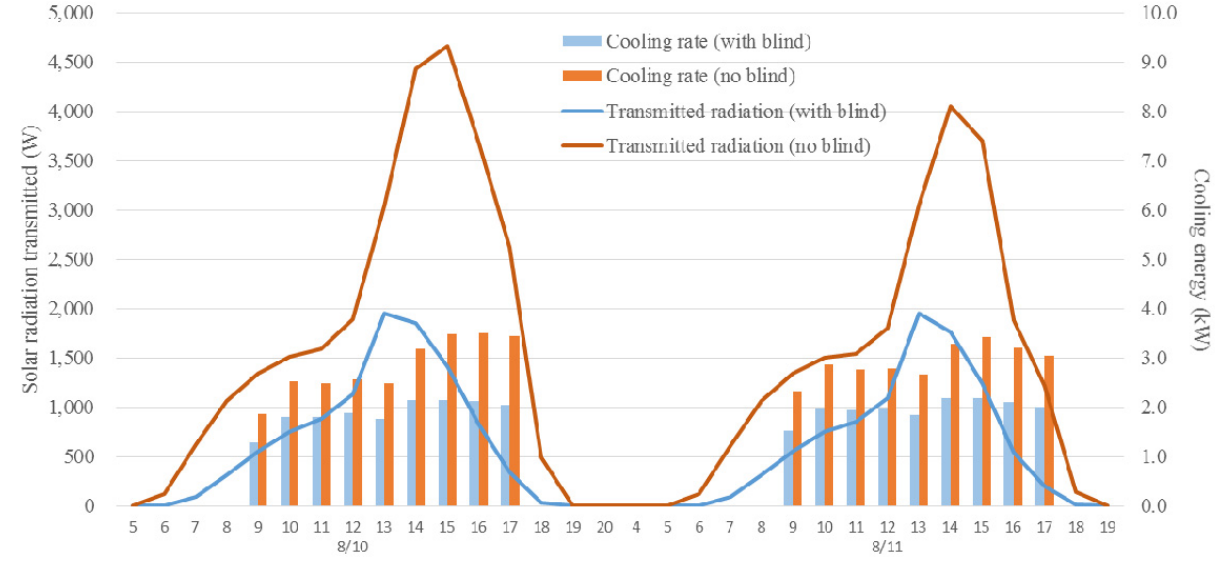
Figure 12. Hourly solar radiation transmitted into indoors and the corresponding cooling energy rates on two typical consecutive summer days in